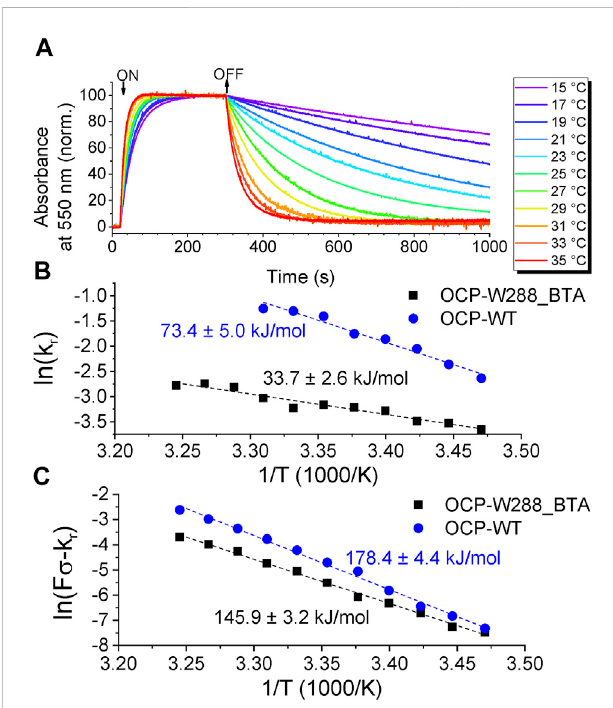
FIGURE 7 Photoconversion of OCP-W288_BTA. (A) Normalized time- courses oftheabsorption changes at550 nmattemperatures from 15 ° C to 35 ° Cupon OCP O → OCP R photoconversionand subsequent relaxation from OCP R to OCP O . (B) Arrhenius plot of the natural logarithm of the rate constants of OD 550 changes ( F · σ ) minus the rate constant of recovery at the same temperature ( r ) during OCP O -to-OCP R photoconversion (obtained with the same illumination intensity) against thereciprocaltemperature. (C) Arrheniusplotofthenaturallogarithmof therateconstants( r )ofOD 550 changesduringrelaxationfromthesteady state reached after constant illumination back to the dark-adapted state against the reciprocal temperature. The line fi ts to the data sets are included yielding the activation energies indicated in the fi gure